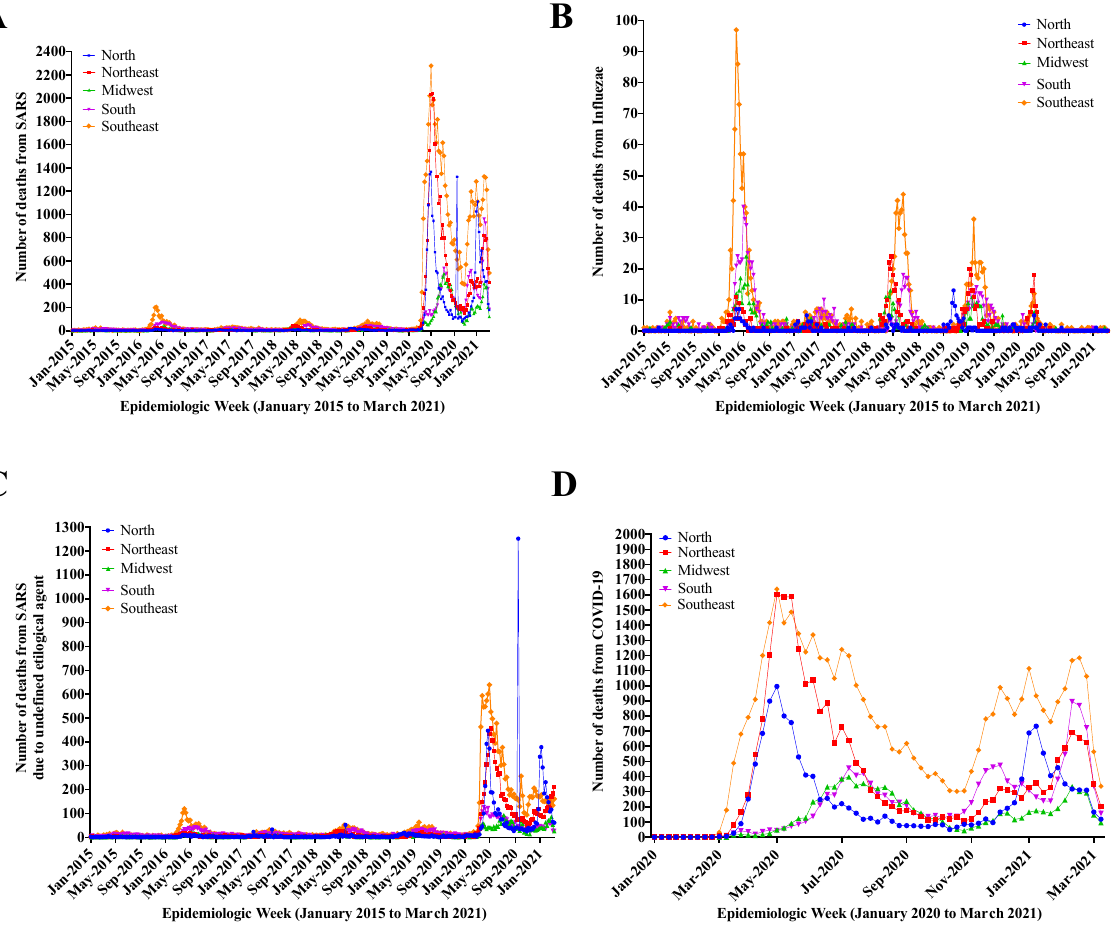
Figure 2. Death from severe acute respiratory syndrome (SARS) overview in Brazil during the study period (January 2015 to March 2021). ( A ) Deaths from SARS regardless of etiological factor. ( B ) Evolution in the number of deaths from SARS resulting from Influenzae. ( C ) Evolution in